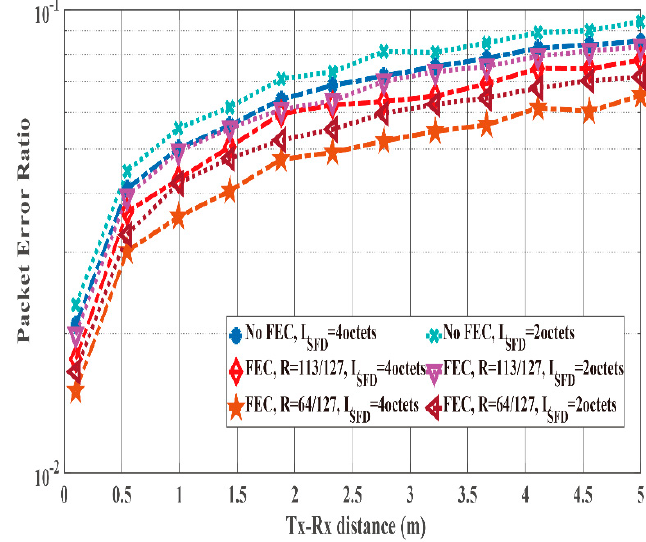
Figure 18. PER performance as a function of the Tx-Rx distance. Case with an SFD ( L SFD = 2 octets and 4 octets).